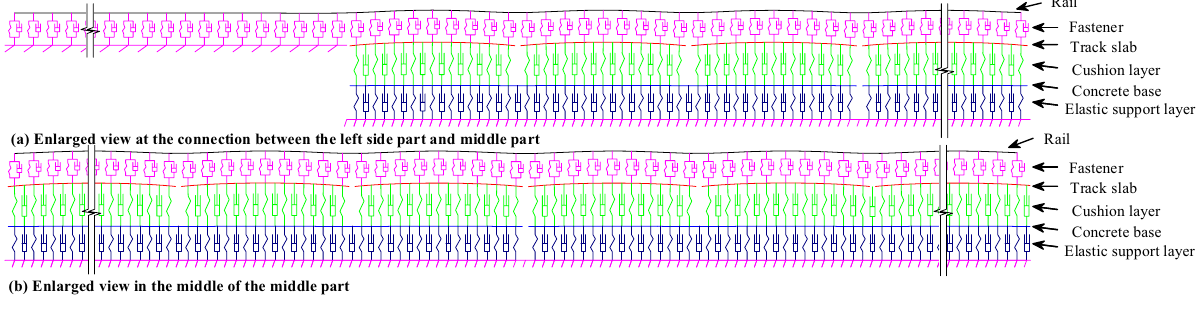
Figure 3. Enlarged view of the submodel.